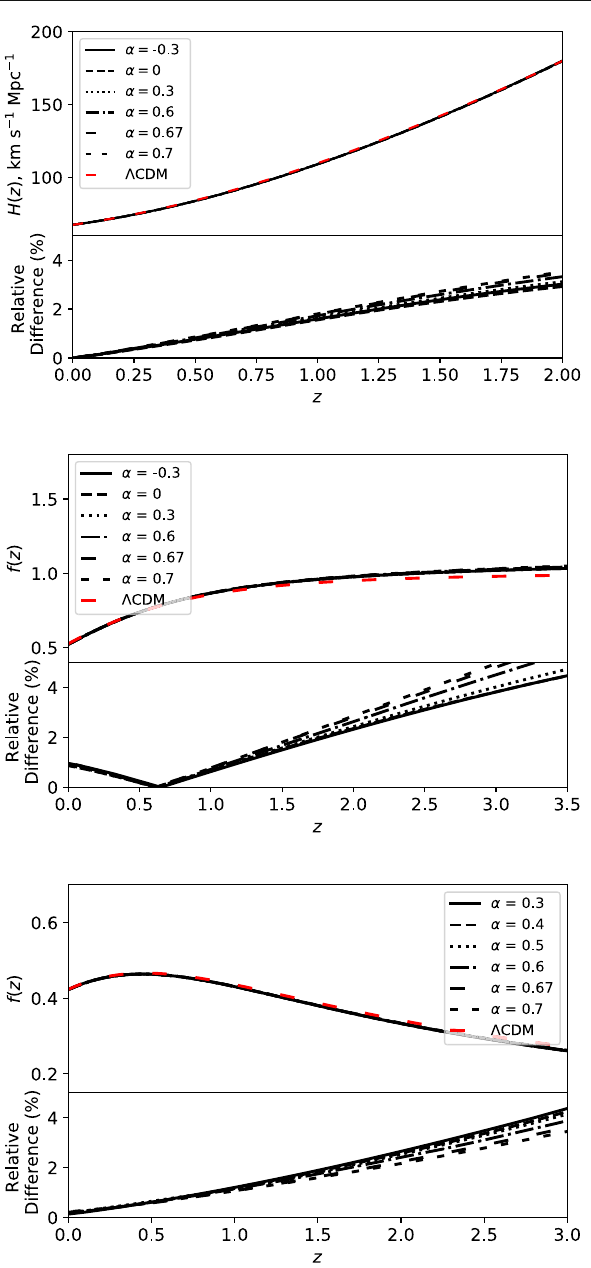
Fig. 12 The evolution of different observables for a fixed time delay and at varying initial histories. Here, H i τ = 5 . 55. The effect of α on observablesisnotstrongatsmallredshiftsandfortimedelays H i τ < 10